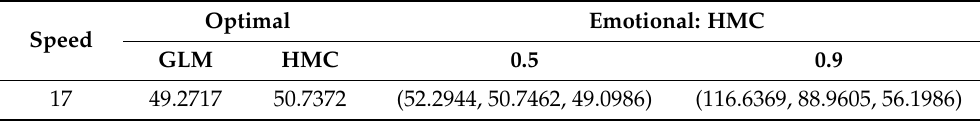
Table 6. Optimal and emotional decisions: car data